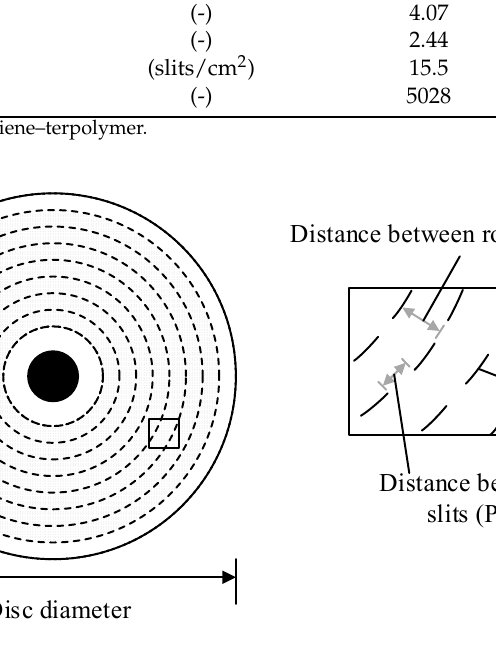
Figure 2. Scheme of disc diffuser membrane design.